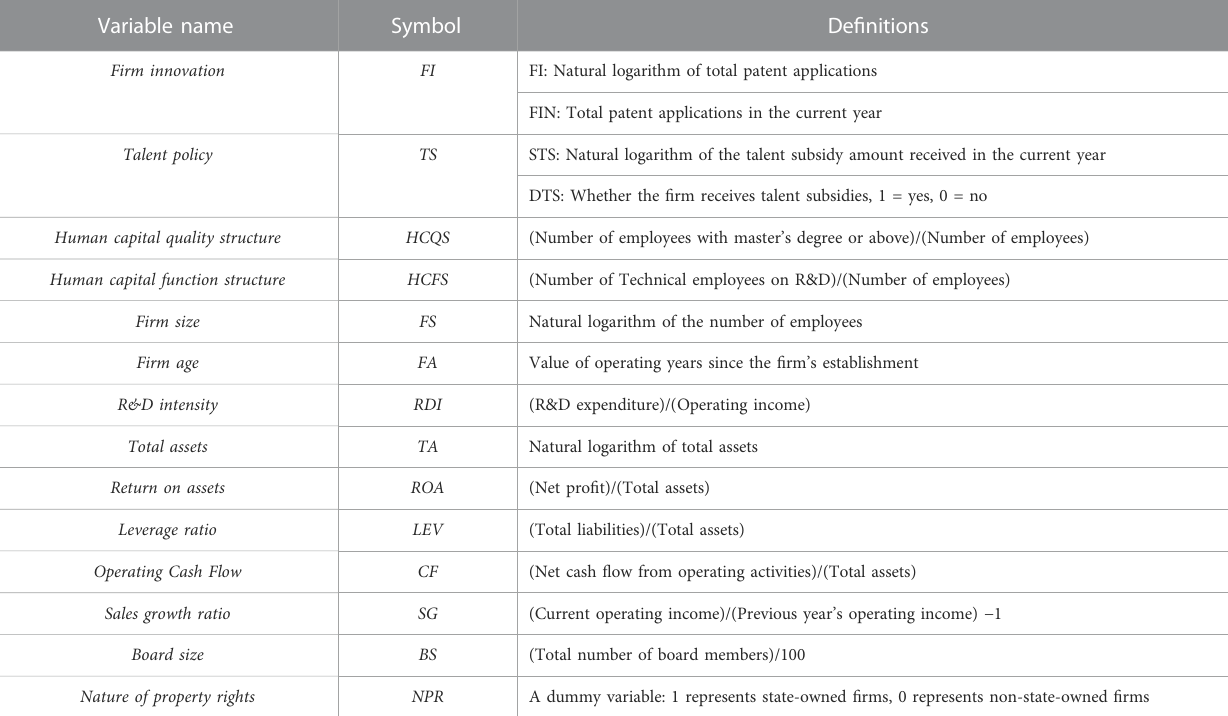
TABLE 1 Variable